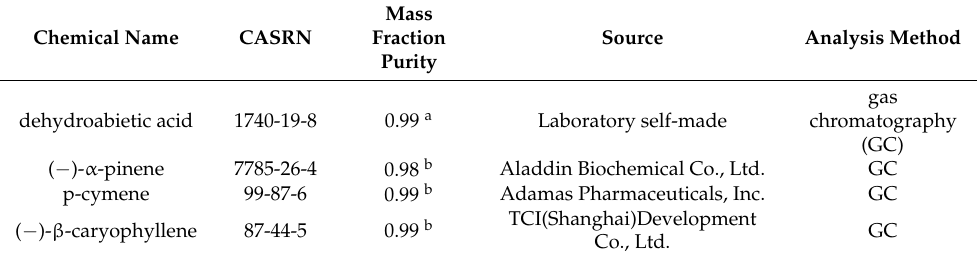
Table 14. Descriptions of the materials used in the